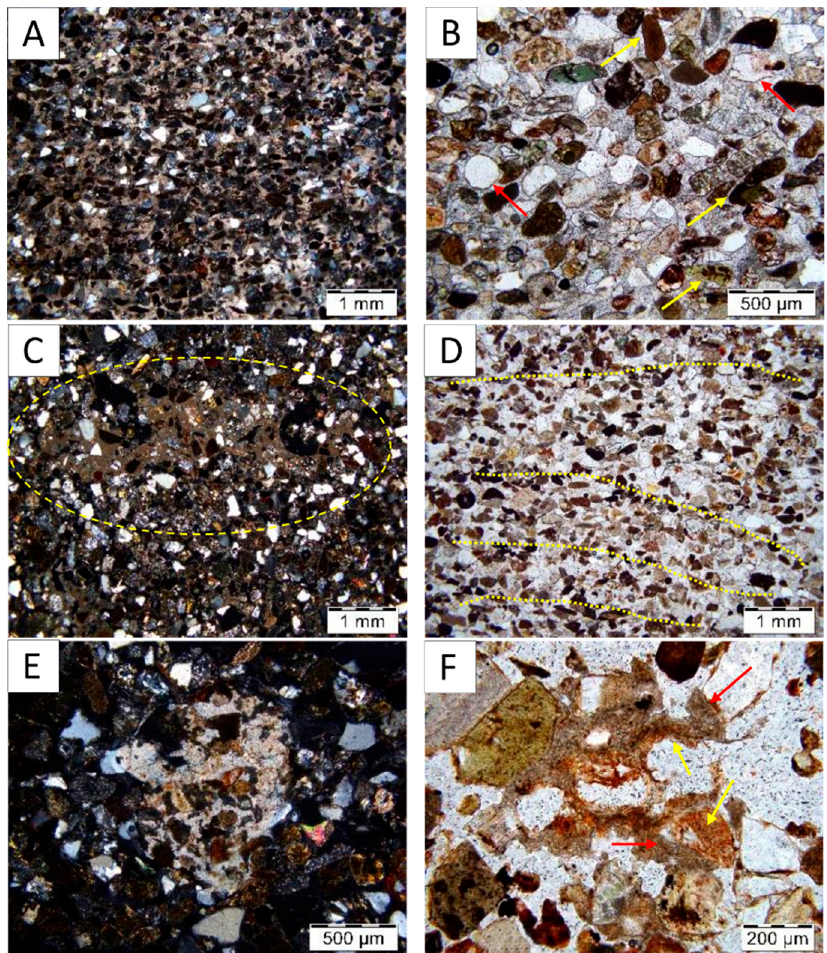
Figure 5. Microfeatures of the groundmass in the surface soil ( A–C ) and in the buried soil ( D–F ). ( A, B ) Microphotographs of the C3 horizon of the surface soil at depth 125–130 cm: calcareous well-cemented sandstone slab, NX ( A ); mineral composition of the sandstone slab, NII ( B ). Please note: the non-opaque sand-grains (marked by yellow arrows), thin coatings on the mineral grains (marked by red arrows). ( C ) Microphotograph of the C2 horizon of the surface soil at depth 95 cm: fragments of weathered calcareous sandstone slab, incorporated in the non-calcareous groundmass; NX. ( D,E ) Microphotographs of the Ckb horizon of the buried soil at depth 110–115 cm: composition of the parent material with the tendency of sand grains to lamination NII ( D ), weathered primary carbonates; NX ( E , F ) Microphotograph of the Cb horizon of the buried soil at depth 60–65 cm: secondary carbonate nodules (marked by red arrows). Please also note the residuals of modern roots in the inner part (marked by yellow arrows).